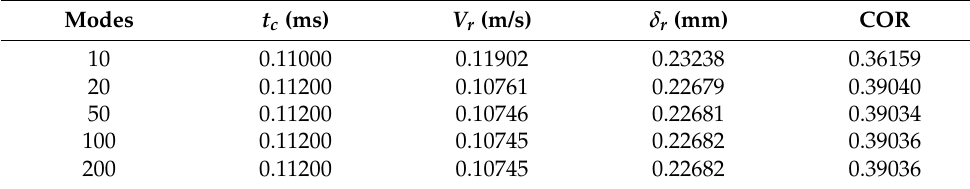
Table 4. Convergence of the truncated mode number.